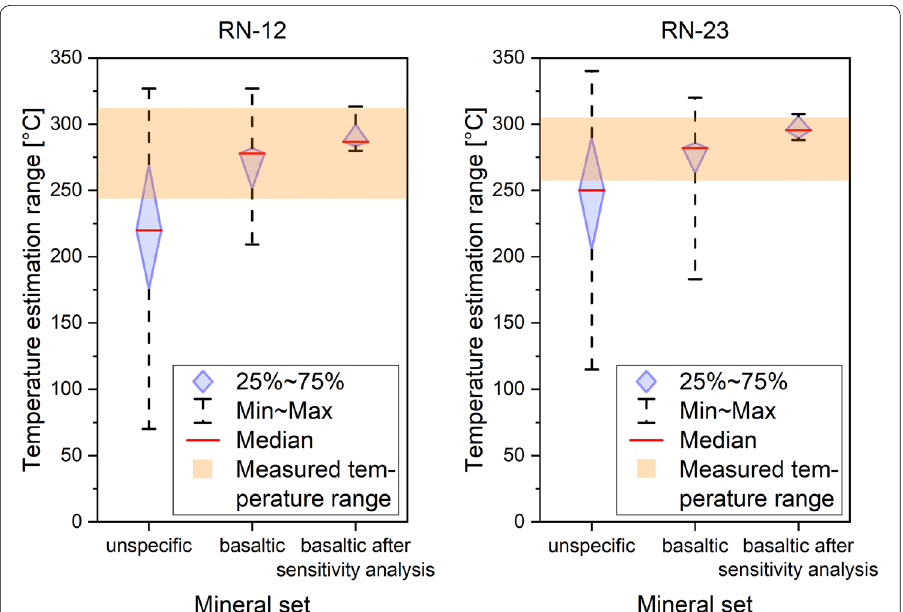
Fig. 10 Results for wells RN-12 and RN-23 for the three stages of the analysis. The first box plot shows a temperature estimation calculated based on an unspecific mineral set. The second column displays the developed basaltic mineral set. The third box plot shows the minimized temperature estimation after the pH, aluminium concentration, and steam loss sensitivity analysis of the specified basaltic mineral set. These box plots can be compared with the range of the measured temperature in the borehole, given by the orange